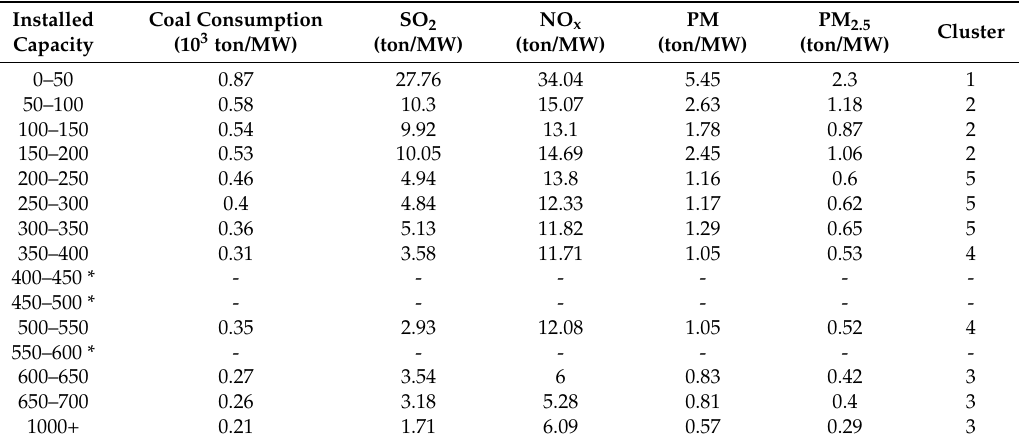
Table 2. K-means clustering of installed efficiency.